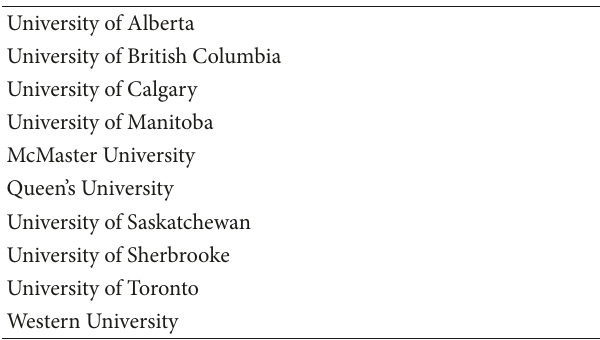
Table 1: Medical schools that participated in the survey.